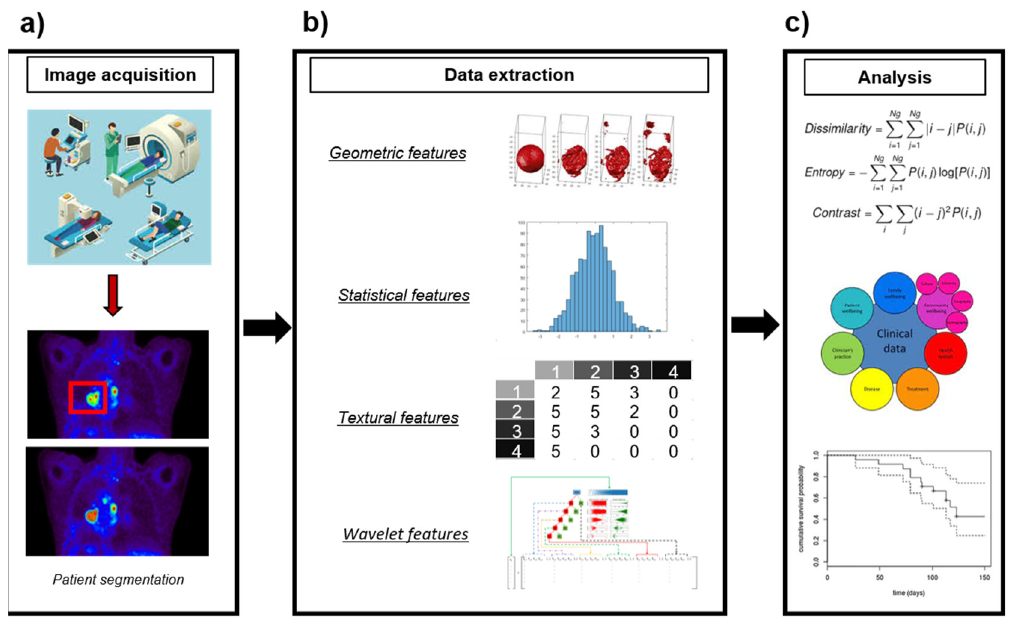
Figure 1. Example of image processing for radiomics. ( a ) Image acquisition and tumor segmentation. ( b ) Extraction of different shape, intensity, and textural features from the segmented tumor. ( c ) Development of prediction models using imaging features.